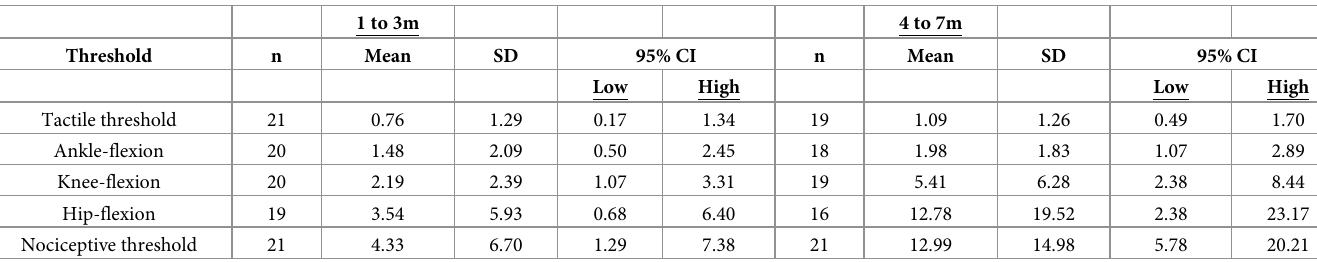
Model 2: Threshold ~ age + GA. Age and duration of general anaesthesia had no signifi- cant effects on tactile sensory thresholds, which is contrary to our hypothesis ( Table 4 ). Noci- ceptive thresholds were significantly predicted by age at the time of study (estimate = 0.13, 95% CI = 0.06 to 0.2, t = 3.93, p < .001; Table 4 ), which is in agreement with our hypothesis. Model 3: Threshold ~ age + GA + ICU-stay. Age, duration of general anaesthesia, and duration of ICU stay had no significant effects on tactile sensory thresholds ( Table 4 ). Table 3. Sensory thresholds (g) in the control group when tested at two ages during infancy. 1 to 3m 4 to